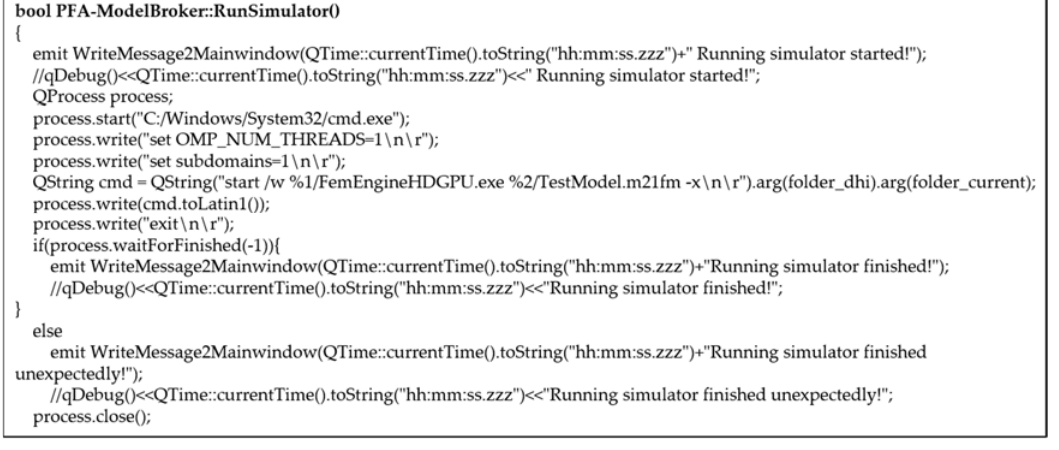
Figure A2. Example of the PFA code for the implantation of the model broker to activate a simulation.